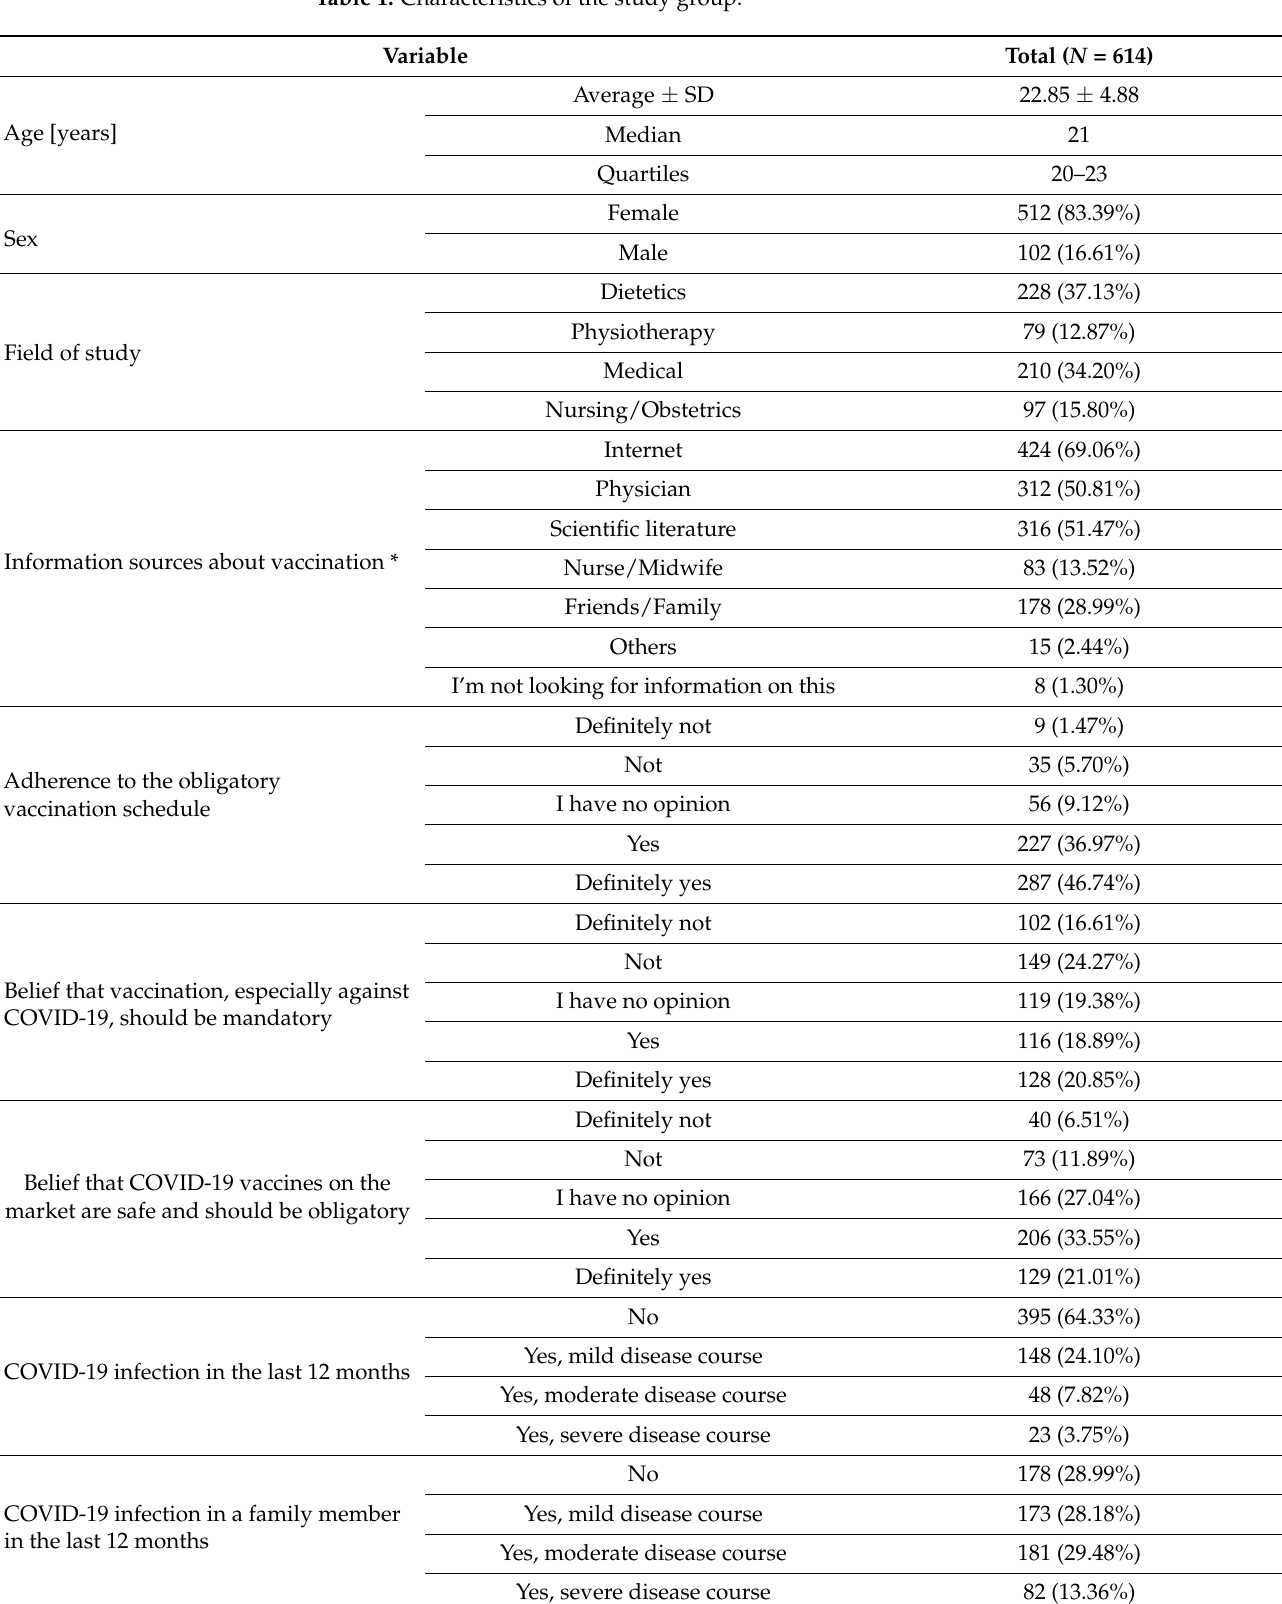
Table 1. Characteristics of the study